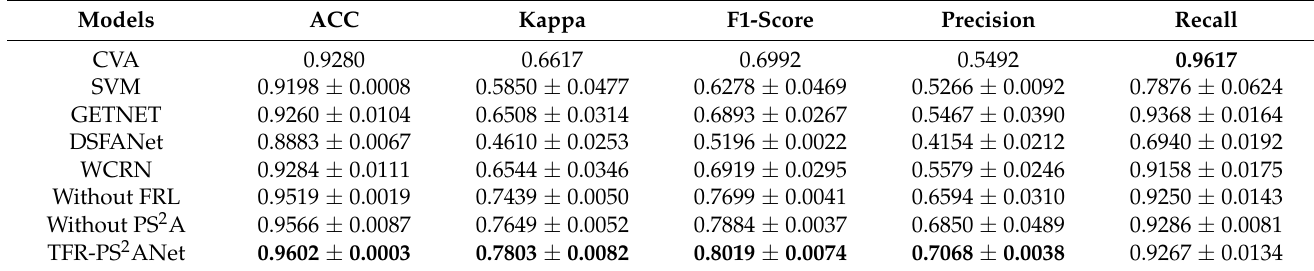
Table 4. Model comparison results and module ablation study results on the River Dataset (repeated 3